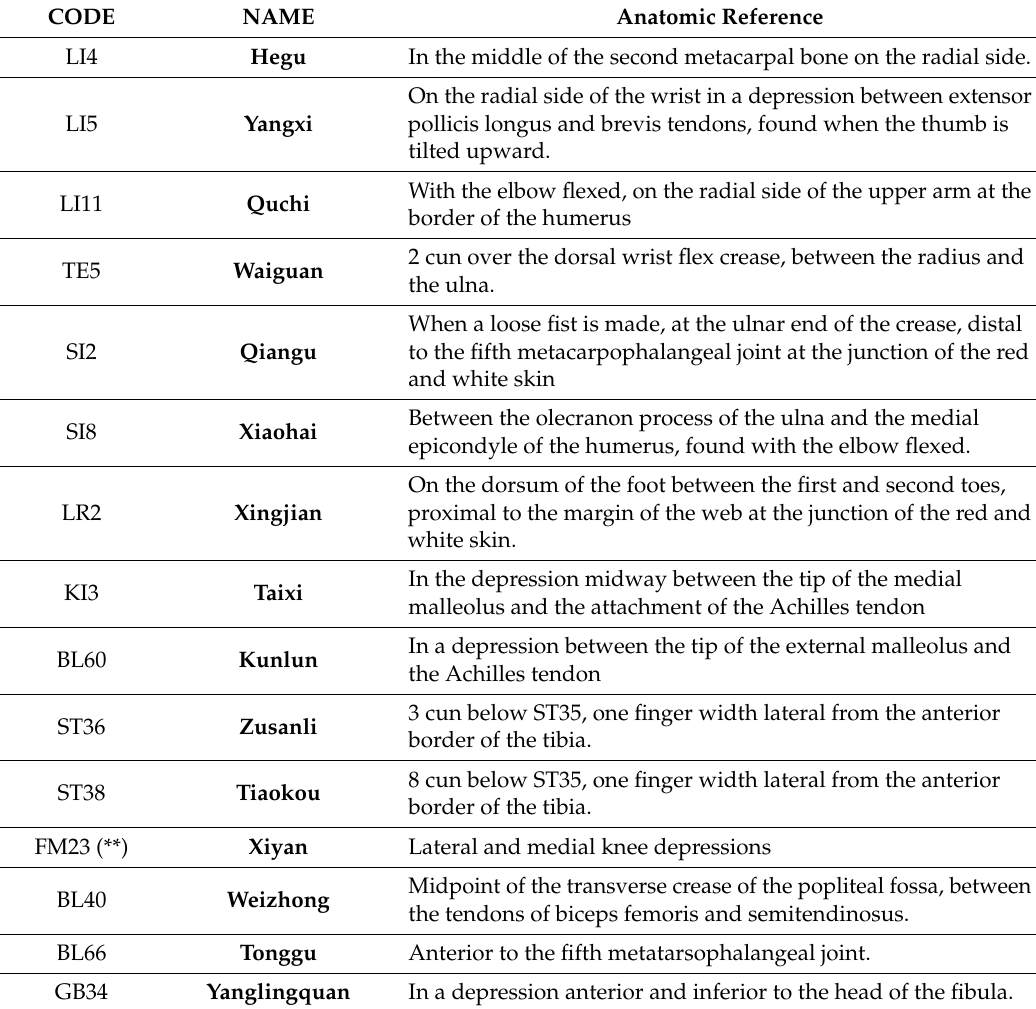
Table 1. Libralux application protocols—Selected Accupoints (*)